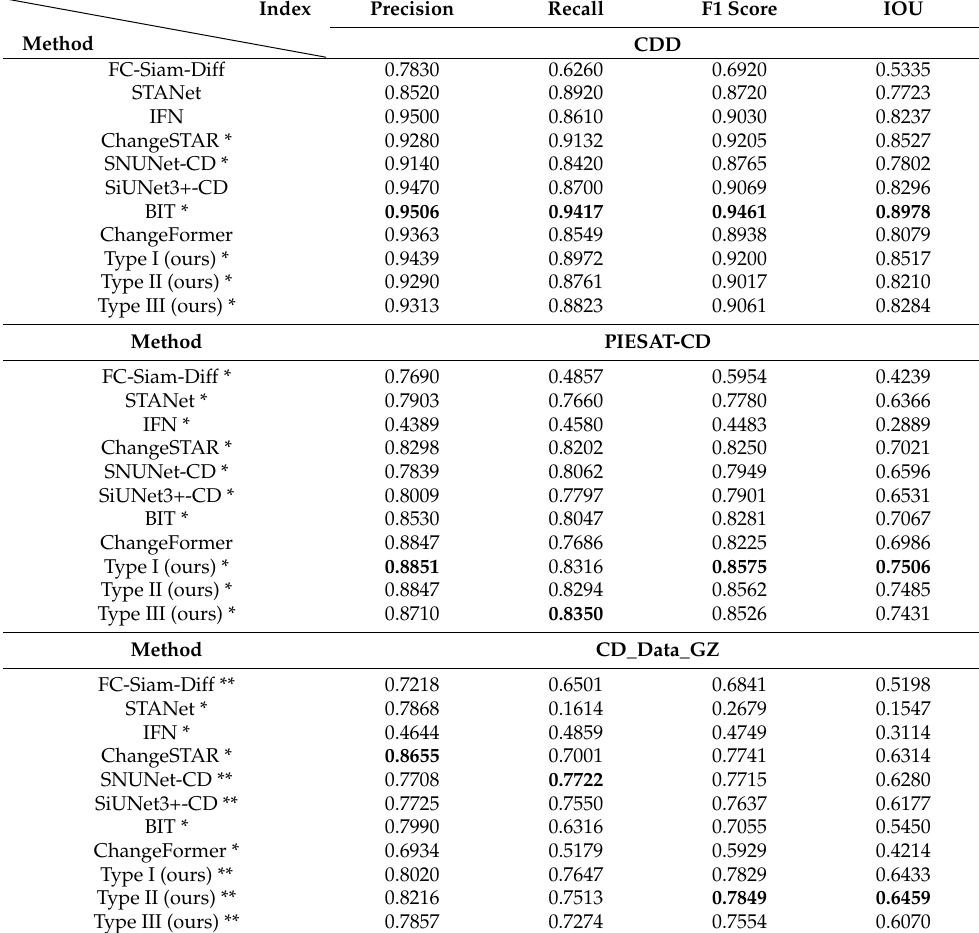
Table 1. Performance comparison on CDD, PIESAT-CD, and CD_Data_GZ datasets.